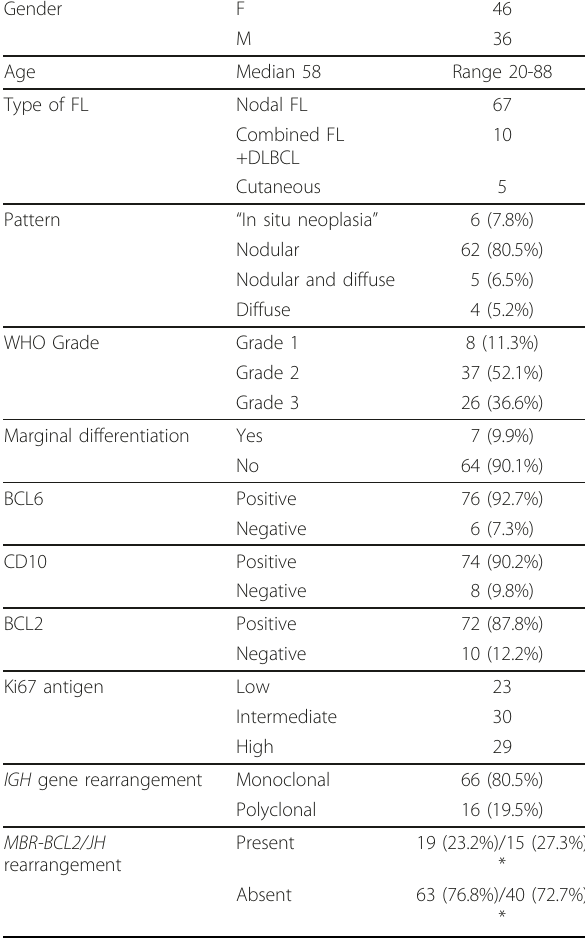
Table 1 Clinical, histological, phenotypical and molecular findings in the series of 82